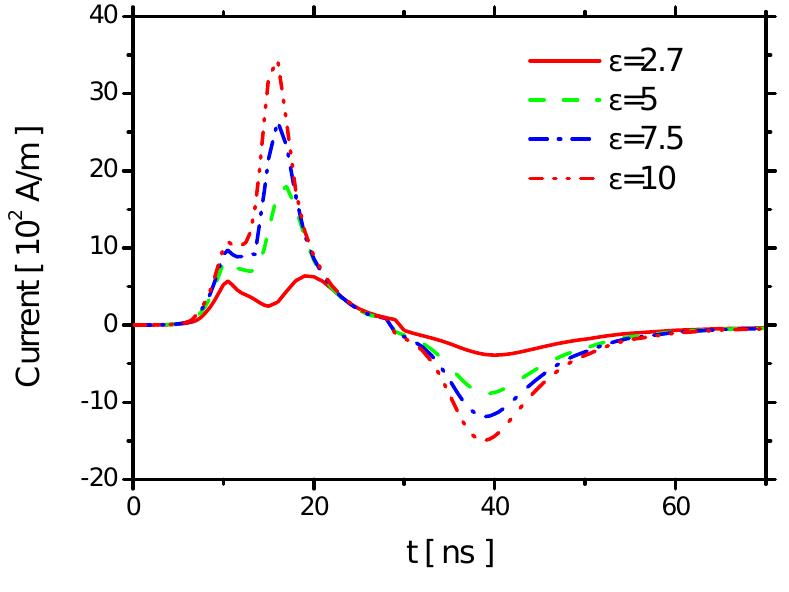
Figure 2. Effects of the dielectric constant ε on the electric field strength electron temperature T e .